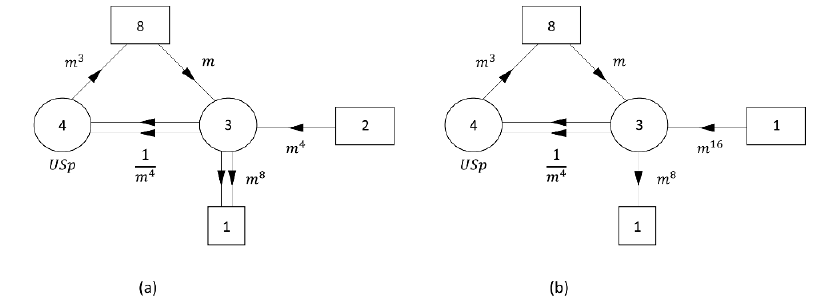
Figure 6 . (a) The 4 d theory associated in [10] with the compacti(cid:12)cation of the minimal ( D 5 ; D 5 ) conformal matter on a torus with (cid:13)ux 1 preserving U(1) (cid:2) SU(8) (cid:2) SO(4). (b) The 4 d theory we get 2 after a mass deformation giving mass to two (cid:13)avors of the SU(3) group. Here in addition to the